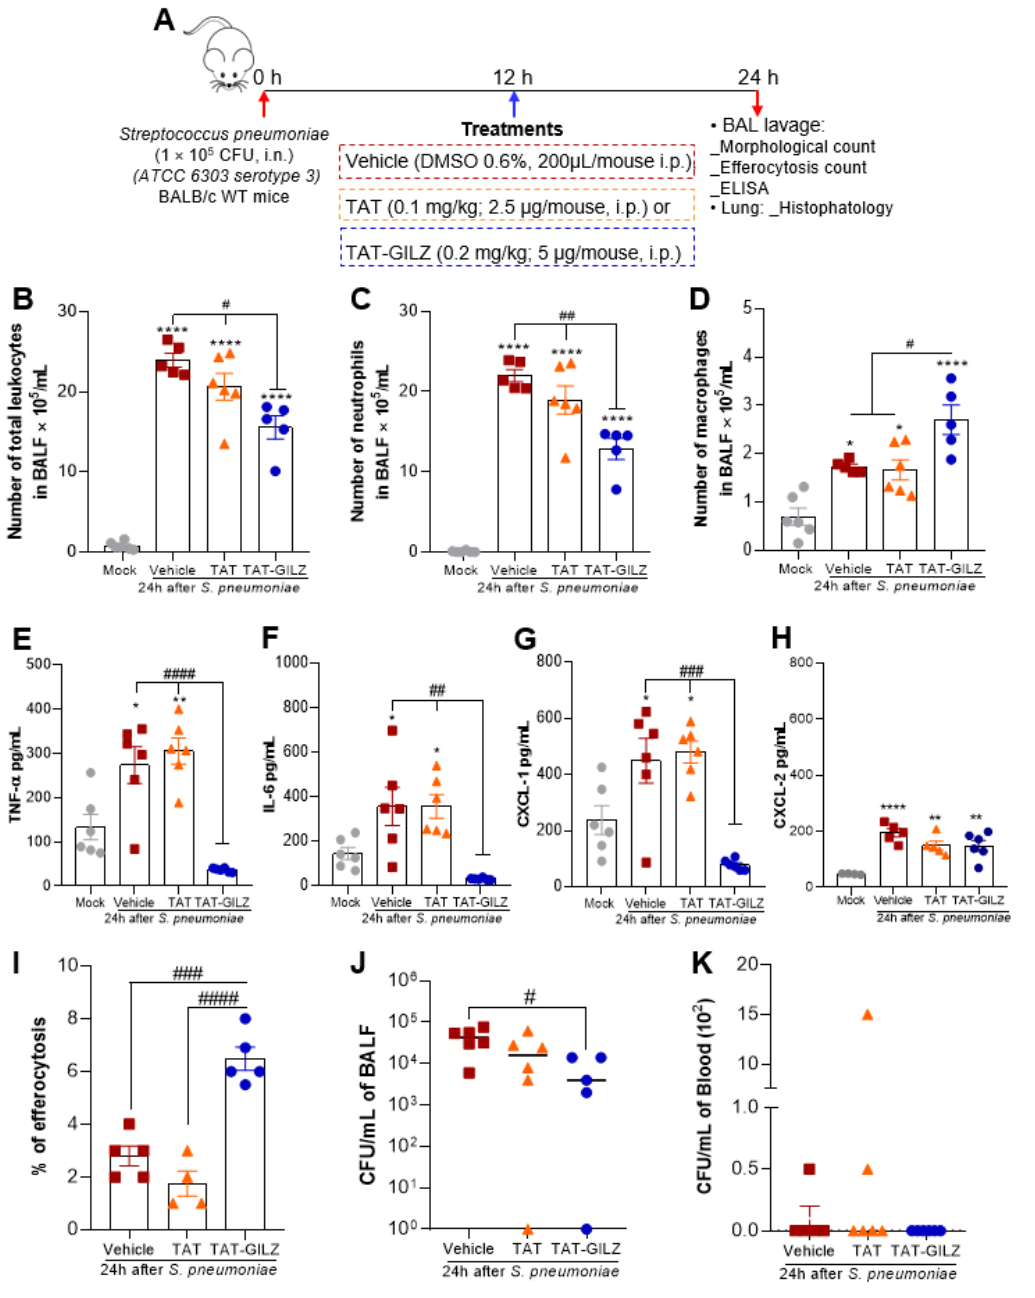
Figure 4. Effect of treatment with TAT-GILZ in the course of pneumococcal pneumonia. BALB/c mice were infected with S. pneumoniae (1 × 10 5 CFU, i.n.) and then treated with TAT (0.1 mg/kg, i.p.) or TAT-GILZ (0.2 mg/kg, i.p.) 12 h p.i. Mice were euthanized 24 h p.i. (schematic protocol in ( A )). Quantification of the number of total leukocytes ( B ), neutrophils ( C ), and macrophages ( D ) in BAL. Measurements of cytokines TNF- α ( E ), IL-6 ( F ) and the chemokines CXCL-1 ( G ) and CXCL-2 ( H ) were performed by ELISA in BAL fluid. Graph ( I ) shows the percentage of efferocytosis (macrophage that had ingested apoptotic cells). Bacterial counts in BALF ( J ) and blood ( K ) were also evaluated. The Mock group (uninfected) received salina and vehicle group received DMSO 0.6%. Data are mean ± SEM of N = 5–6 animals per group. * p < 0.05, ** p < 0.01 or **** p < 0.0001 when compared to the mock group (saline instilled); or as indicated by # p < 0.05, ## p < 0.01, ### p < 0.001 or #### p < 0.0001 when comparing TAT-GILZ-treated pneumococcal pneumonia to vehicle or TAT groups, by 1-way ANOVA.